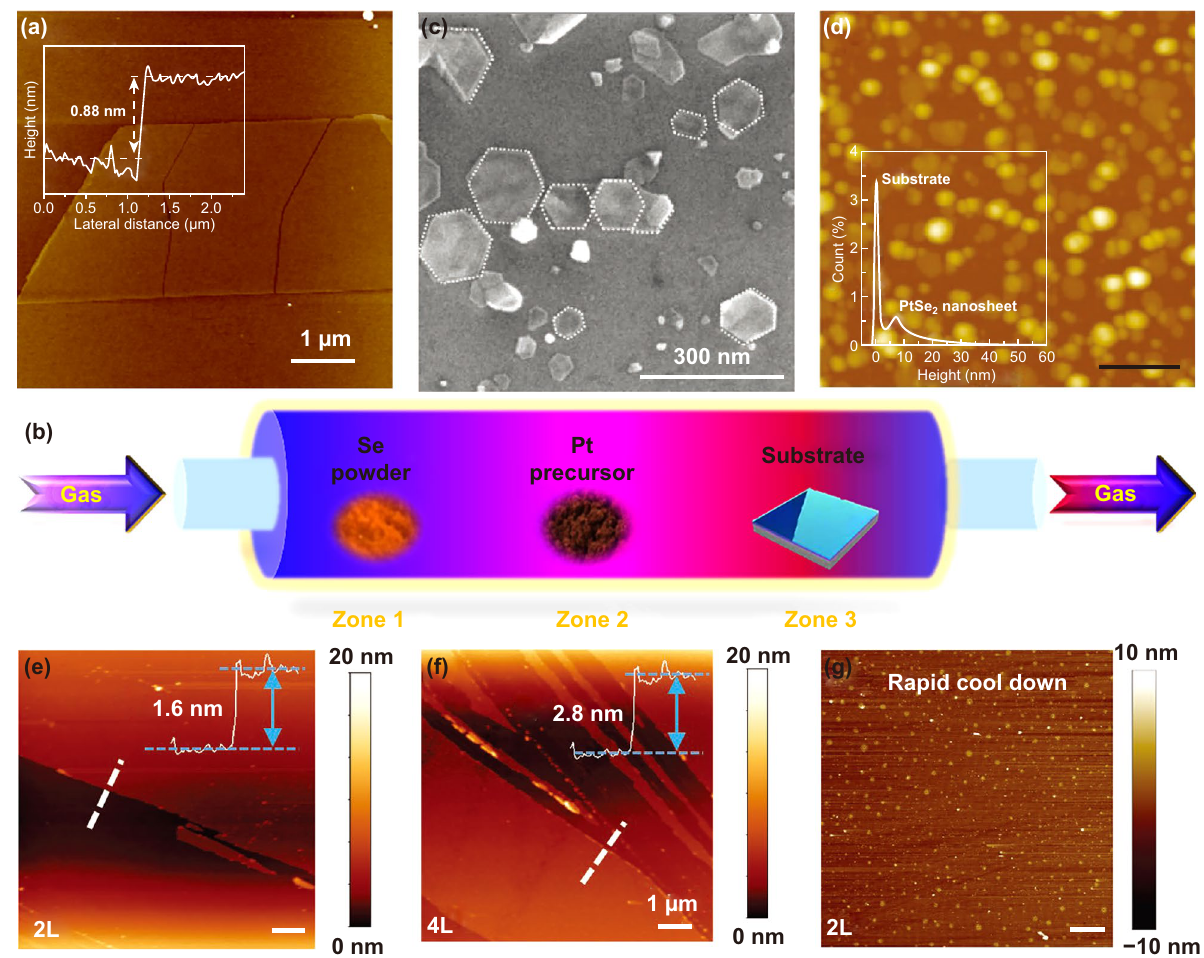
Fig. 7 2D PtSe 2 prepared by Mechanical exfoliation/CVD. a AFM image of the exfoliated monolayer PtSe 2 and corresponding height profiles. Reproduced with permission [28]. Copyright 2018, John Wiley and Sons. b Schematic diagram of the three zones CVD system for the synthesis of 2D PtSe 2 . c SEM morphology of the PtSe 2 nanosheets synthesized by CVD process. d AFM image of the PtSe 2 nanosheets synthesized by CVD process. c , d Reproduced with permission [106]. Copyright 2016, John Wiley and Sons. The AFM image of the e bilayer and f four layer PtSe 2 film and corresponding height profiles [107]. g AFM image of the bilayer PtSe 2 synthesized via rapid cool down process. e–g Reproduced with permission [107]. Copyright 2019, John Wiley and